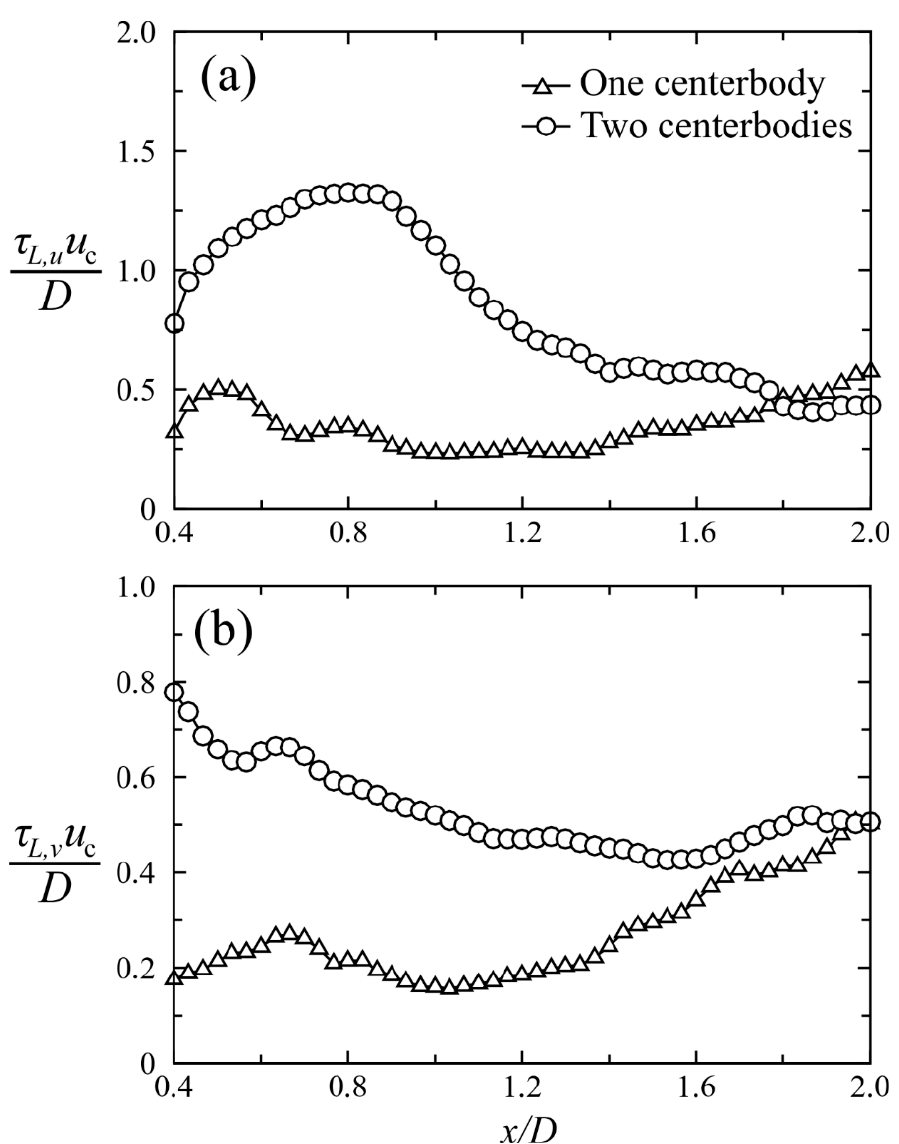
Figure 11. Normalized Lagrangian integral time scales of turbulence eddies along centerline. ( a ) Axial component, ( b ) radial component. Re c = 280, Re a = 480, and S = 0.432.